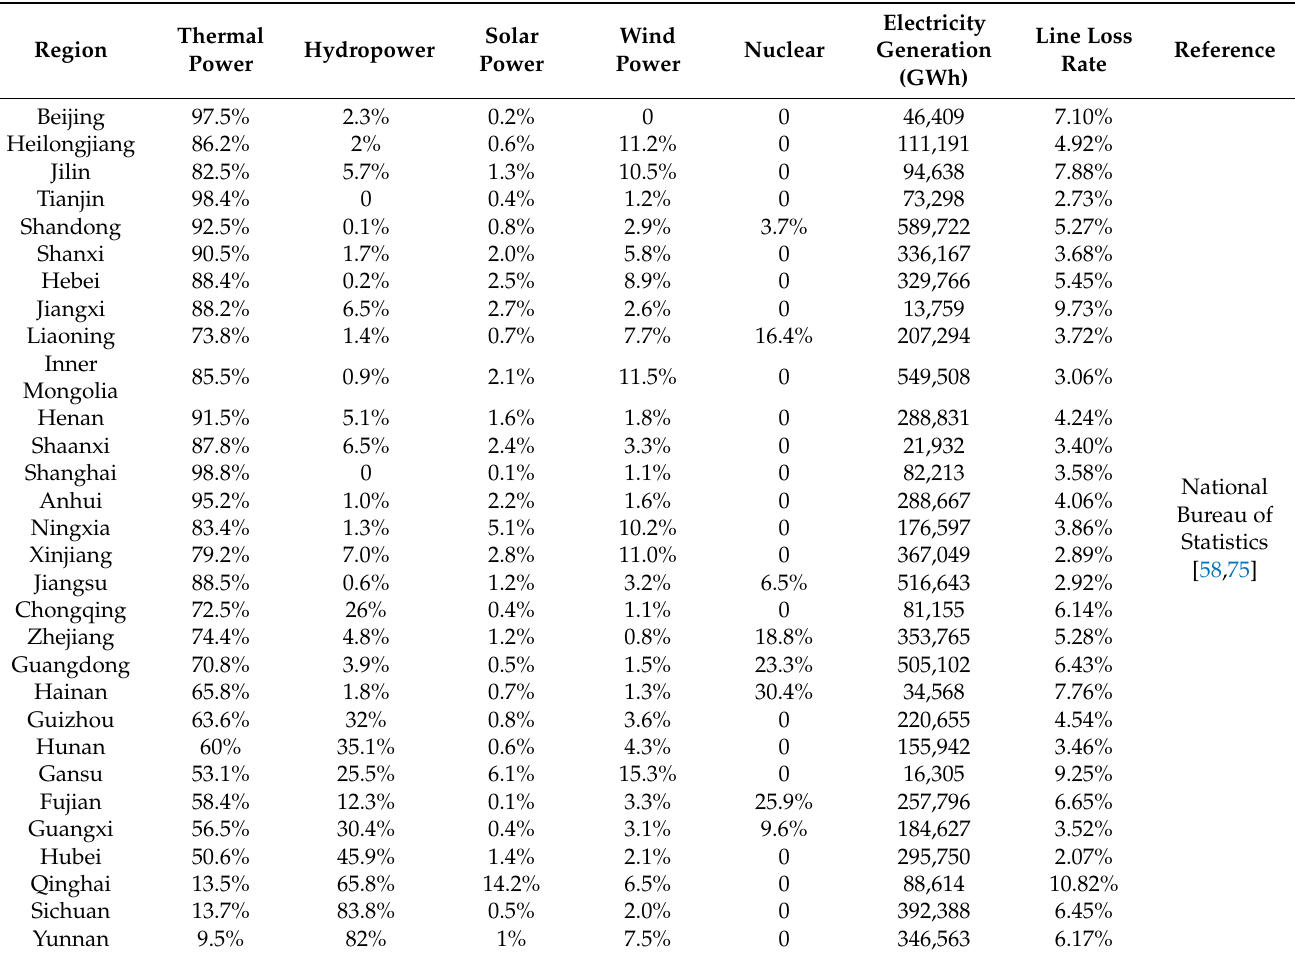
Table 4. Regional electricity generation mix in China in